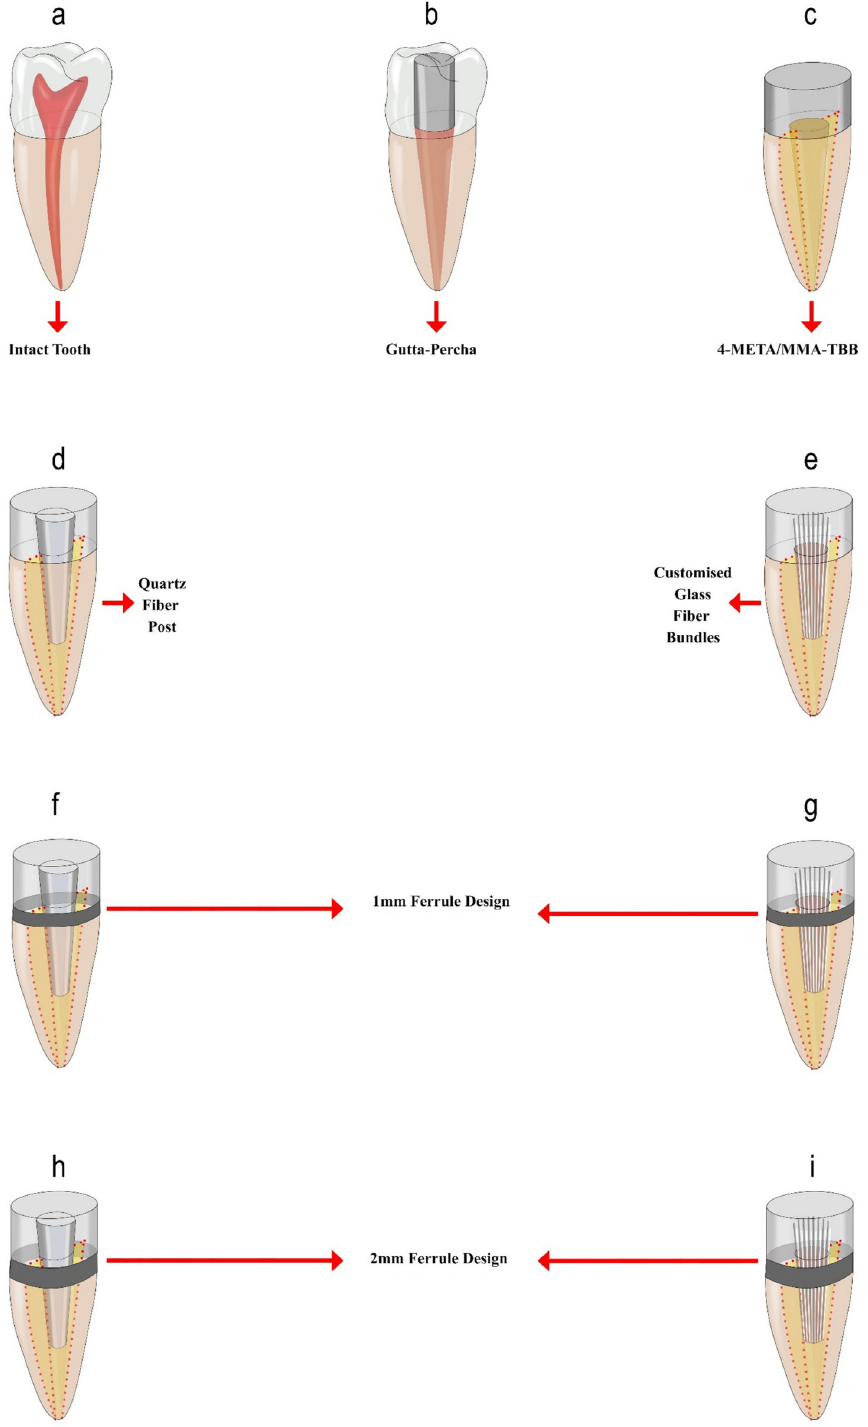
Fig 1. Reattachment designs of the experimental groups. (a) Negative control group (b) Positive control group (c) CB group (d) DT group (e) TB group (f) DT+1F group (g) TB+1F group (h) DT+2F group (i) TB+2F group.